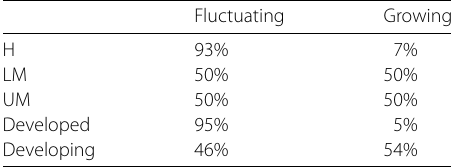
Table 5 Repartition of countries between those having mainly an increasing trend, and the others, for different developing index categories (World Bank classification in high (H)/upper middle (UM)/lower middle (LM), and United Nations classification in Developed and Developing) Fluctuating Growing H 93% 7% LM 50% 50% UM 50% 50% Developed 95% 5% Developing 46%